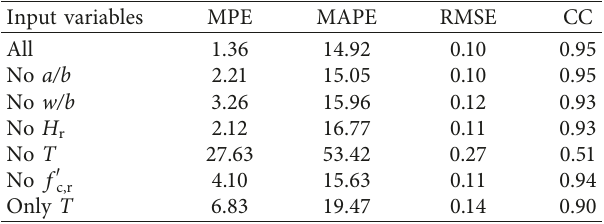
Table 4: Sensitivity analysis with feedforward back propagation for different sets of input